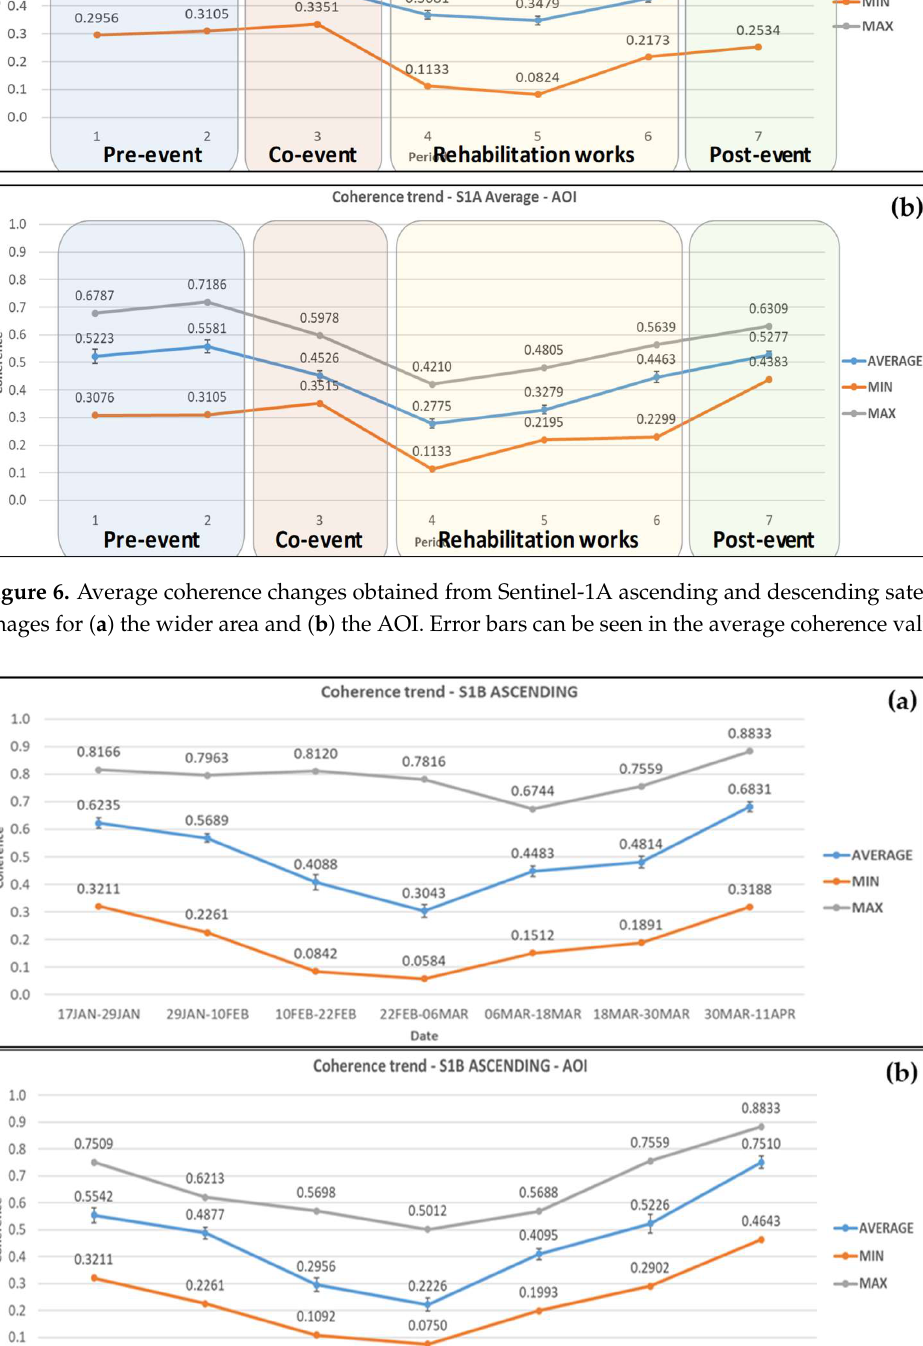
Figure 6. Average coherence changes obtained from Sentinel-1A ascending and descending satellite images for ( a ) the wider area and ( b ) the AOI. Error bars can be seen in the average coherence values.